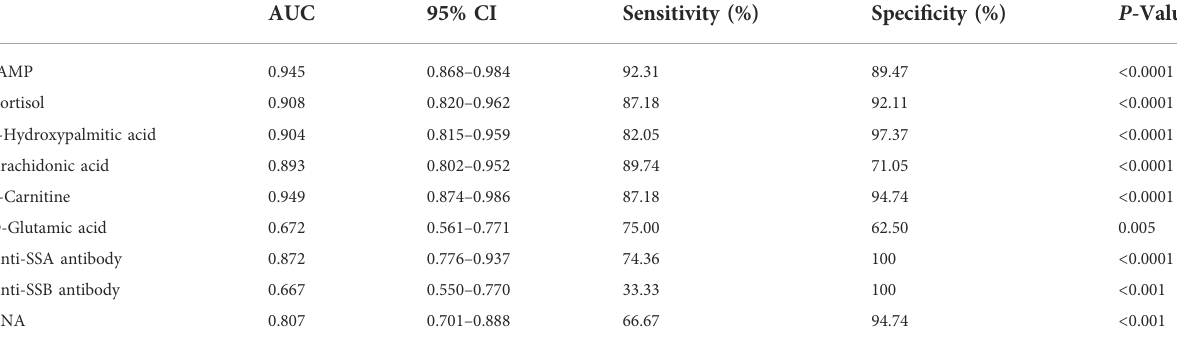
TABLE 3 ROC curve analysis of clinical characteristics and six common